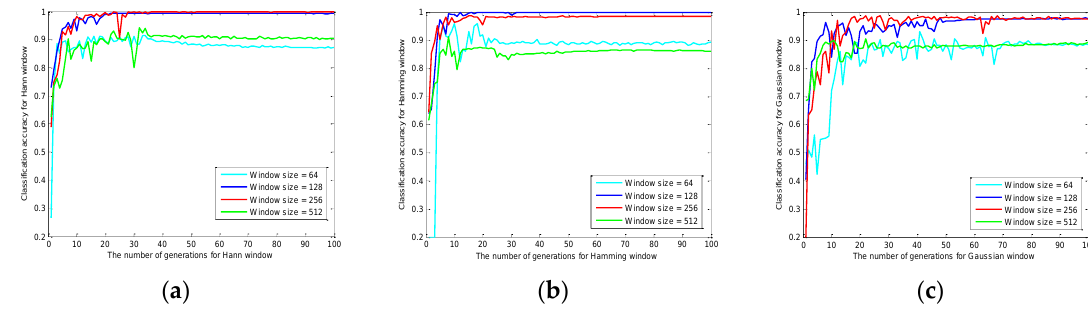
Figure 8. ( a ) Classification accuracy for Hann window with different window size; ( b ) classification accuracy for Hamming window with different window size; ( c ) classification accuracy for Gaussian window with different window size.